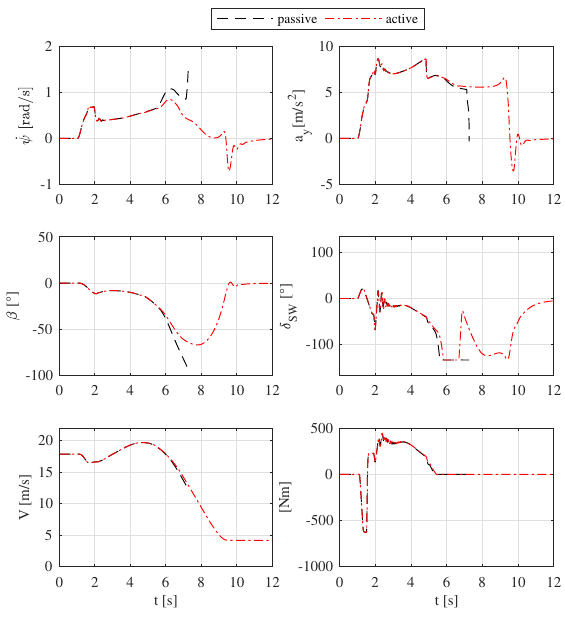
Figure 16. U-turn, µ jump, highly skilled driver, dynamics